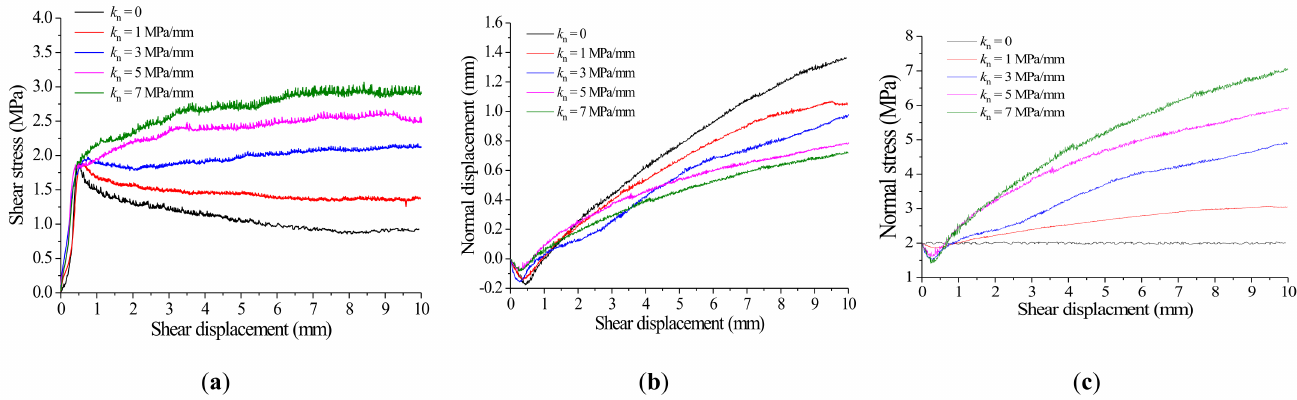
Figure 4. Shear actions of joints under various normal stiffness statuses. ( a ) Shear stress versus shear displacement of joints. ( b ) Normal displacement versus shear displacement of joints. ( c ) Normal stress versus shear displacement of